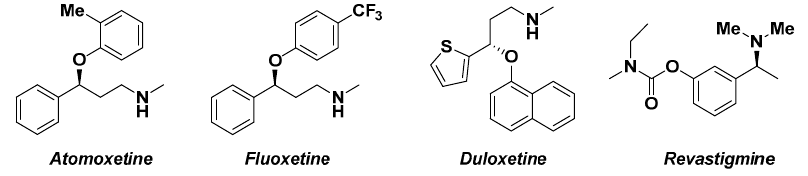
Figure 2. Pharmacologically active homochiral analogues.